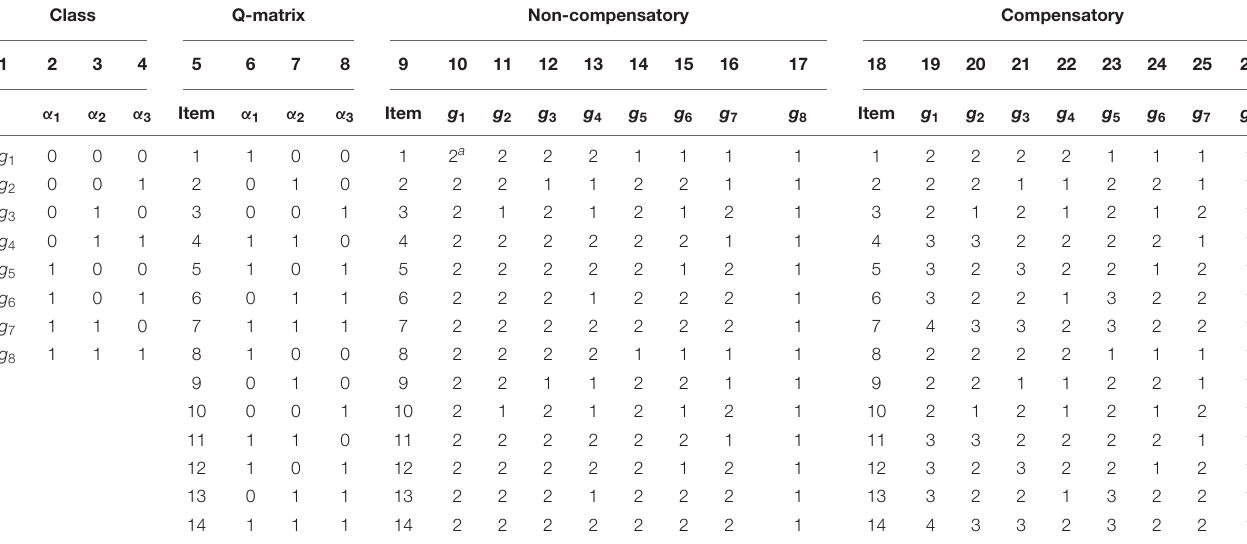
a The 2 represents the label we are using for the threshold in Item 1. Therefore, the whole line to label the first threshold of Item 1 is 2. More importantly, each parameter with a label of 2 in Item 1 will be equated, thus providing the same value for the estimated threshold. The label 2 between each item is different; the 2 is the label, not the